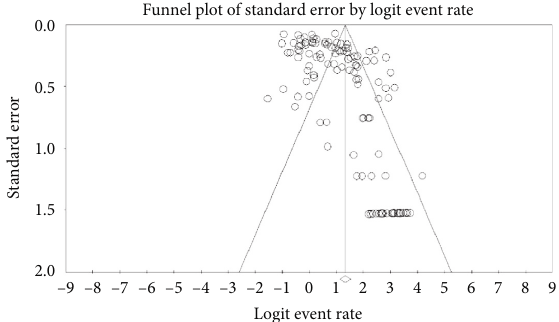
Figure 2: Funnel plot of the results of aflatoxin M1 in